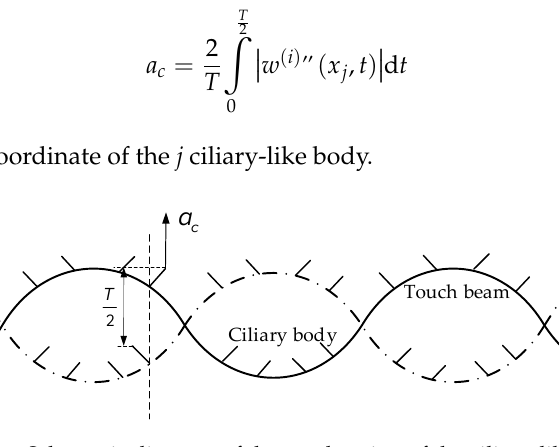
( d ) Figure 11. Image of the vibration acceleration of the ciliary-like body and its parameters. ( a ) a c - ω image of ciliary-like body; ( b ) a c - 3 V image of ciliary-like body; ( c ) a c - e 31 image of ciliary-like body; ( d ) a c -x j image of ciliary-like body. From Figure 11 the following can be noted.